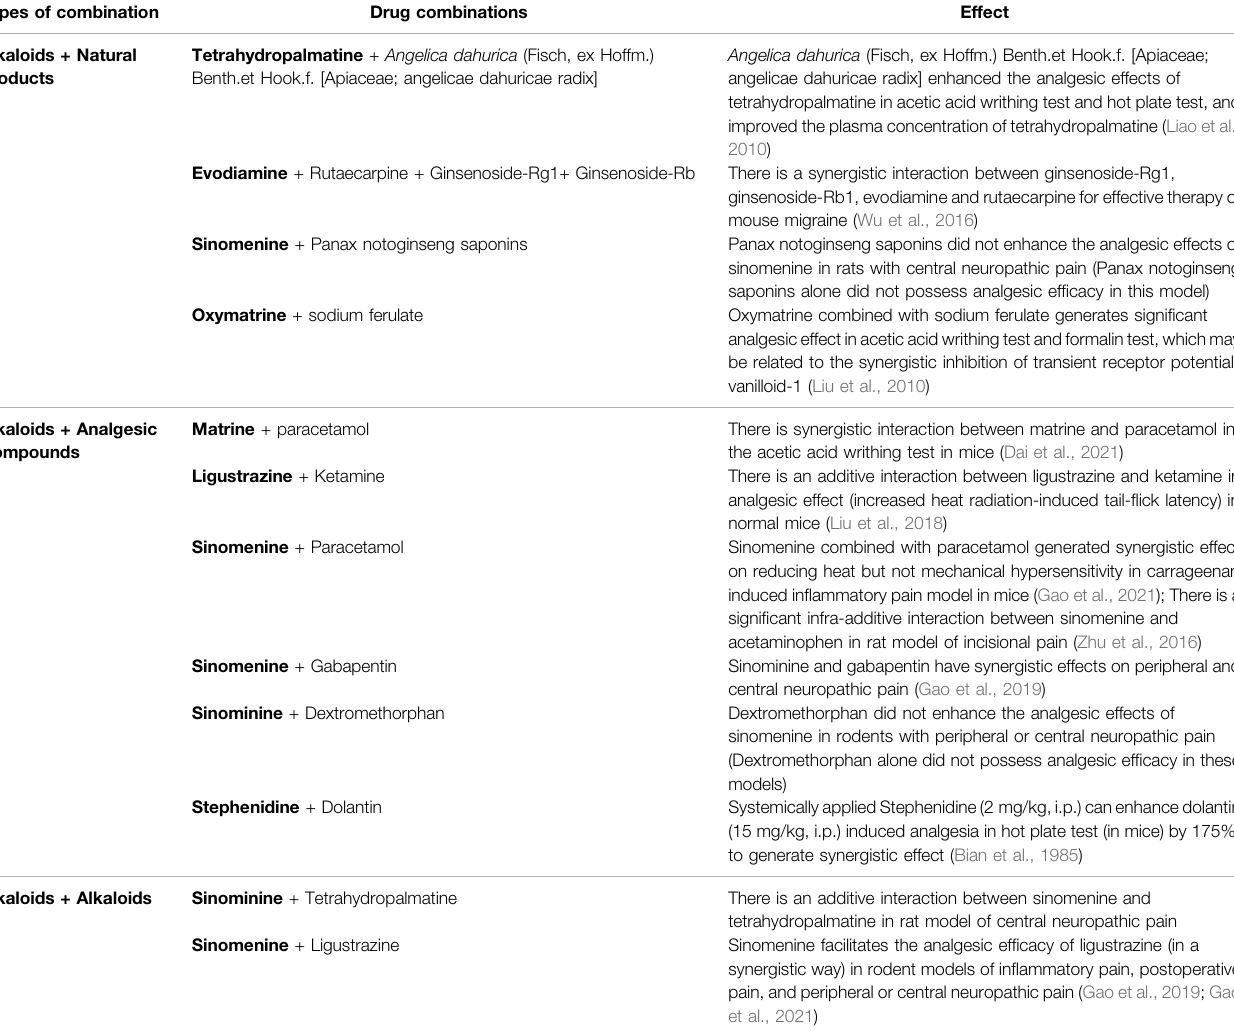
TABLE 3 | Combinational therapies involving TCM derived analgesic alkaloids. Types of